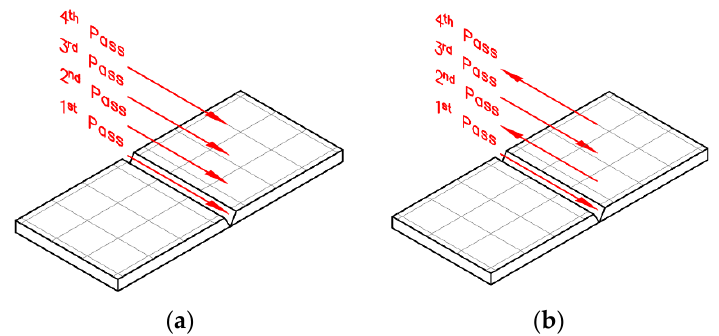
Figure 4. Multipass welding sequence: ( a ) single orientation and ( b ) alternated orientation. The base metal, even before the welding process, shows geometrical discontinuities.